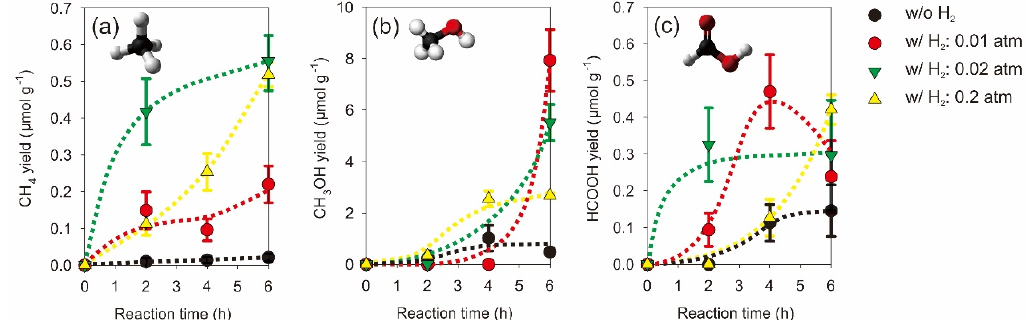
Figure 7. The time-dependent yield of ( a ) CH 4 evolution, ( b ) CH 3 OH formation, and ( c ) HCOOH formation over 1 wt % Pt/CuAlGaO 4 photocatalyst under different H 2(g) partial pressures in a liquid phase reactor. Lines are not based on a kinetic model and are presented for eye-guiding only.